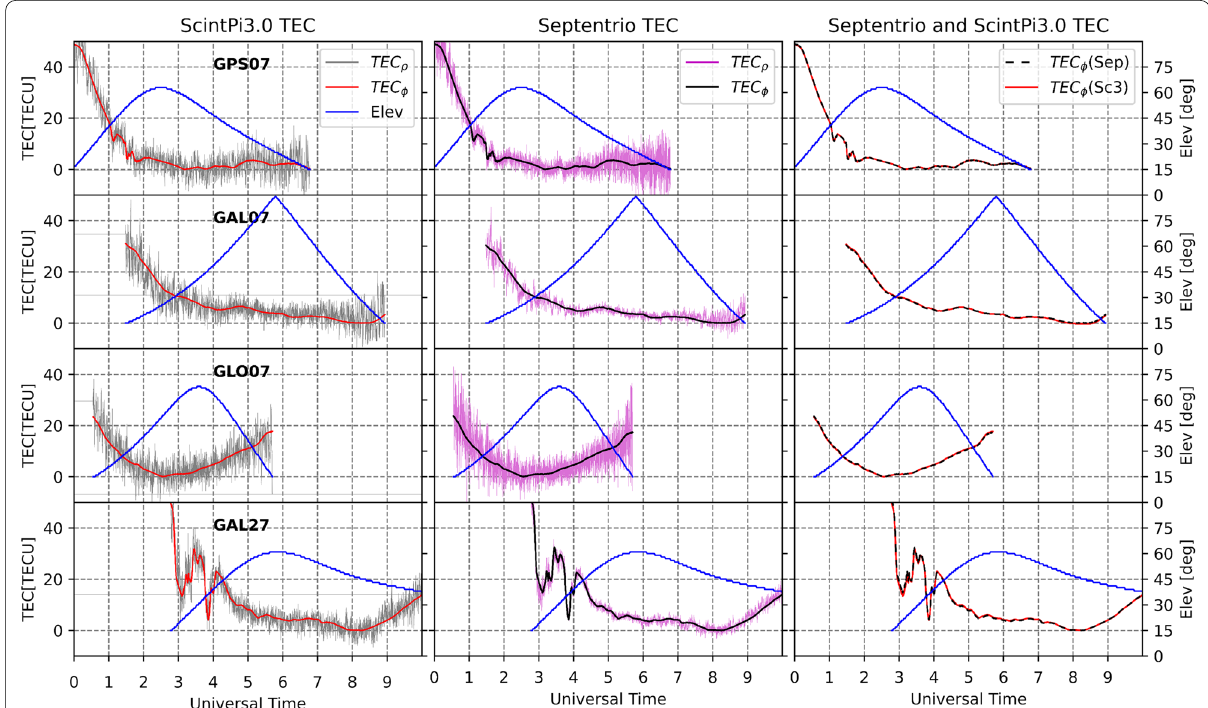
Fig. 8 Comparisons between code TEC and phase TEC measurements made on December 27, 2021 by ScintPi 3.0 and Septentrio PolaRx5S. These monitors were collocated in Presidente Prudente,